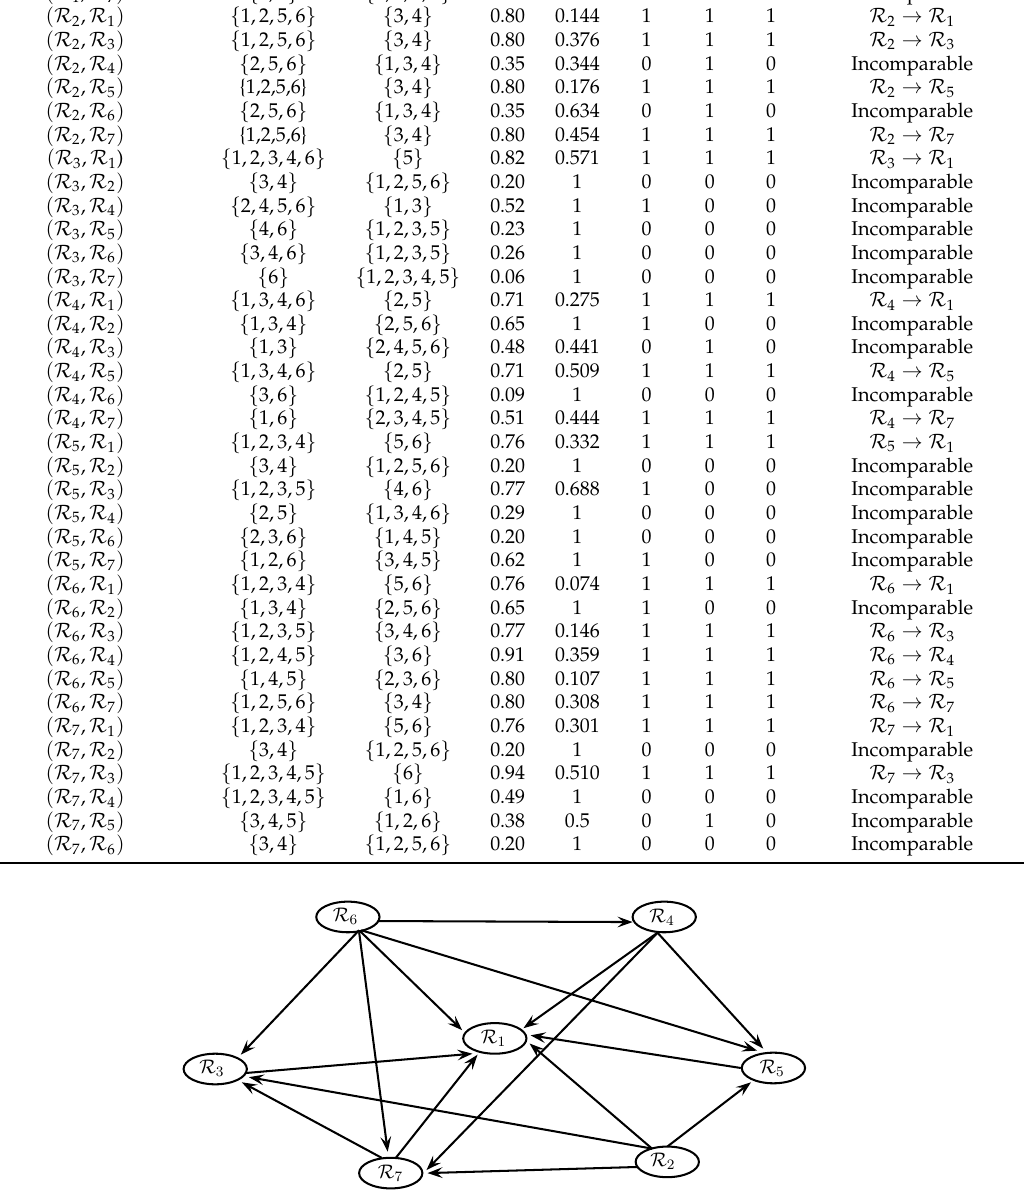
Figure 7: Graph representing the outranking relation of alternatives Figure 7. Graph representing the outranking relation of